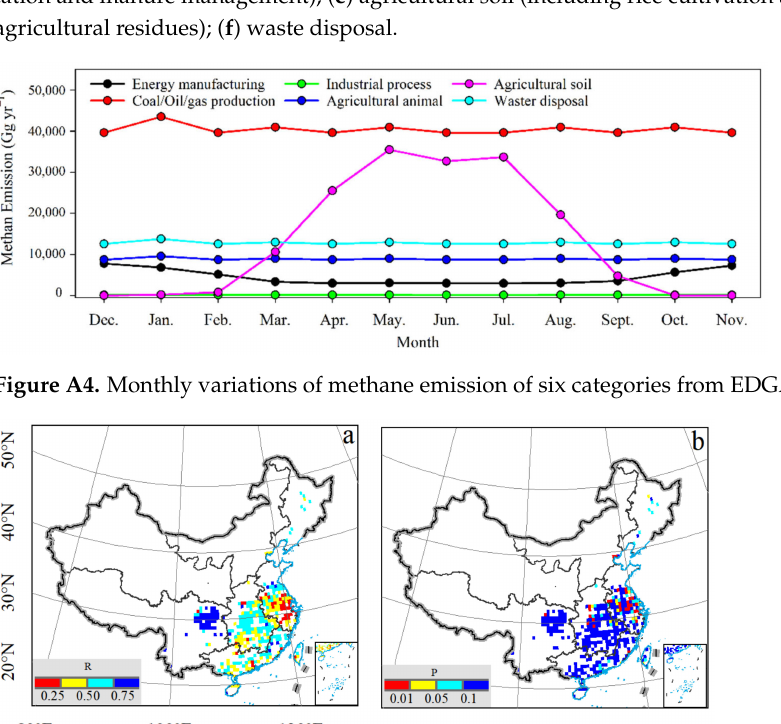
Figure A5. Spatial patterns of correlation coefficients between the seasonal atmospheric methane concentration and rice growth. ( a ) The spatial distributions of Pearson’s correlation coefficients between XCH 4 and EVI; ( b ) The spatial distributions of significance levels of Pearson’s correlation between XCH 4 and